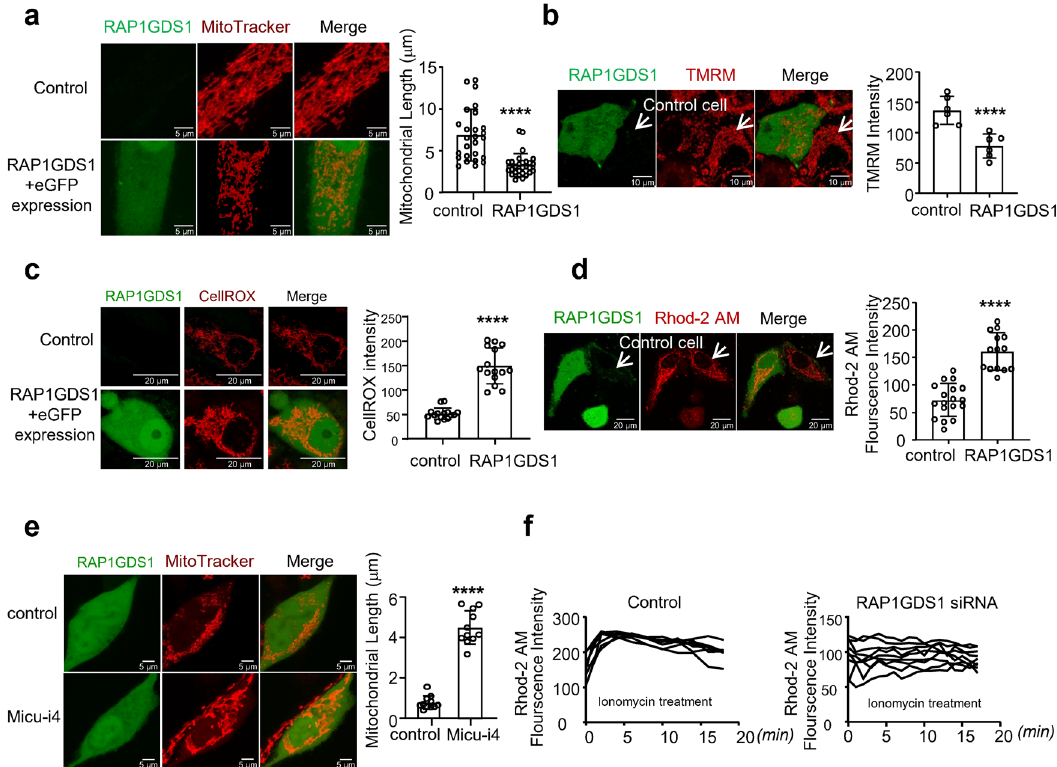
Fig. 4 RAPGDS1 function on mitochondria in cultured cells. The U87-MG cells were transfected with a Pljm1-RAP1GDS1-eGFP vector which expresses RAP1GDS1 and eGFP independently. a Representative live image of mitochondrial morphology by Mito Tracker red. The green channel is RAP1GDS1; the red channel is mitochondria. Scale bar, 5 μ m. The bar graph is the mitochondrial length quanti fi ed by ImageJ. Cell number N = 26 (control, without RAP1GDS1 expression) and 28 (test, with RAP1GDS1 expression). Unpaired t-test. **** P < 0.0001. b Representative live image of mitochondrial membrane potential stained by TMRM. Scale bar, 10 μ m. GFP positive cells are RAP1GDS1 overexpressed. GFP negative is the control cells. The red intensity of TMRM